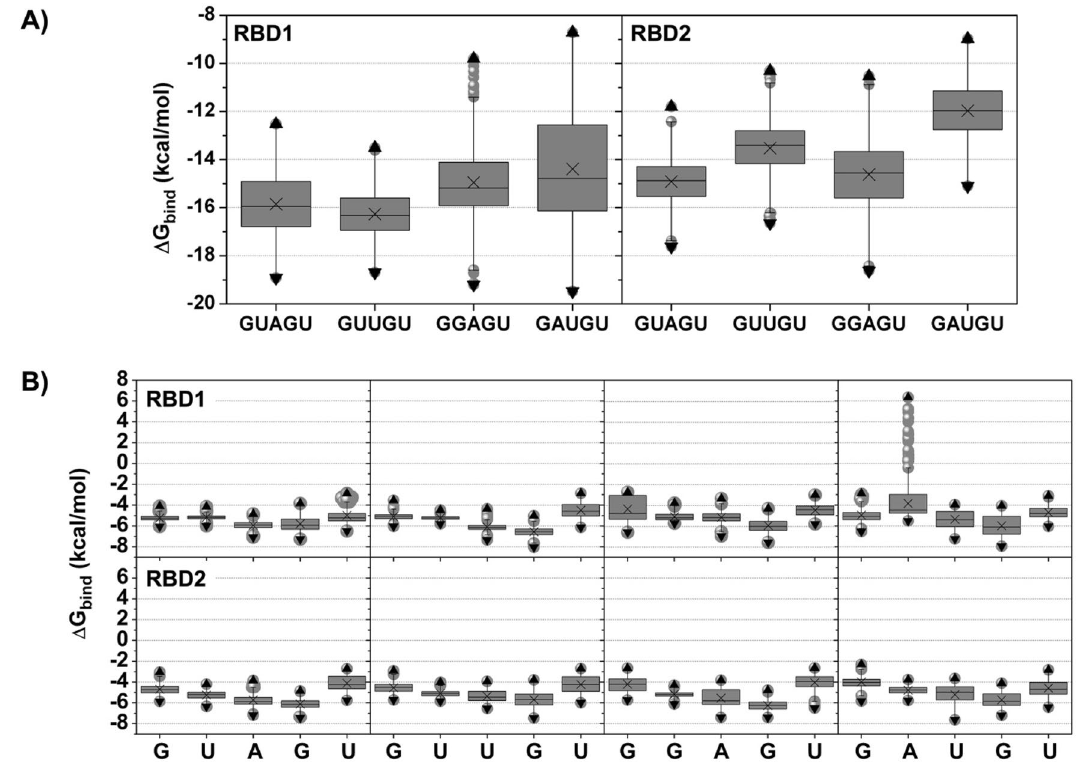
Figure 4. Binding free energies (Δ G bind ) of pentanucleotide ( A ) and individual nucleotide ( B ) binding to MSI1–RBD1/2, calculated by the solvated interaction energy method. Data are taken from the last 20 ns of all five simulations (1000 snapshots in total). Grey boxes cover the area between the 25th and 75th percentiles, with crosses indicating the mean value. Whiskers determine 5th, and 95th percentiles, respectively. Upward and downward triangles represent maximum and minimum